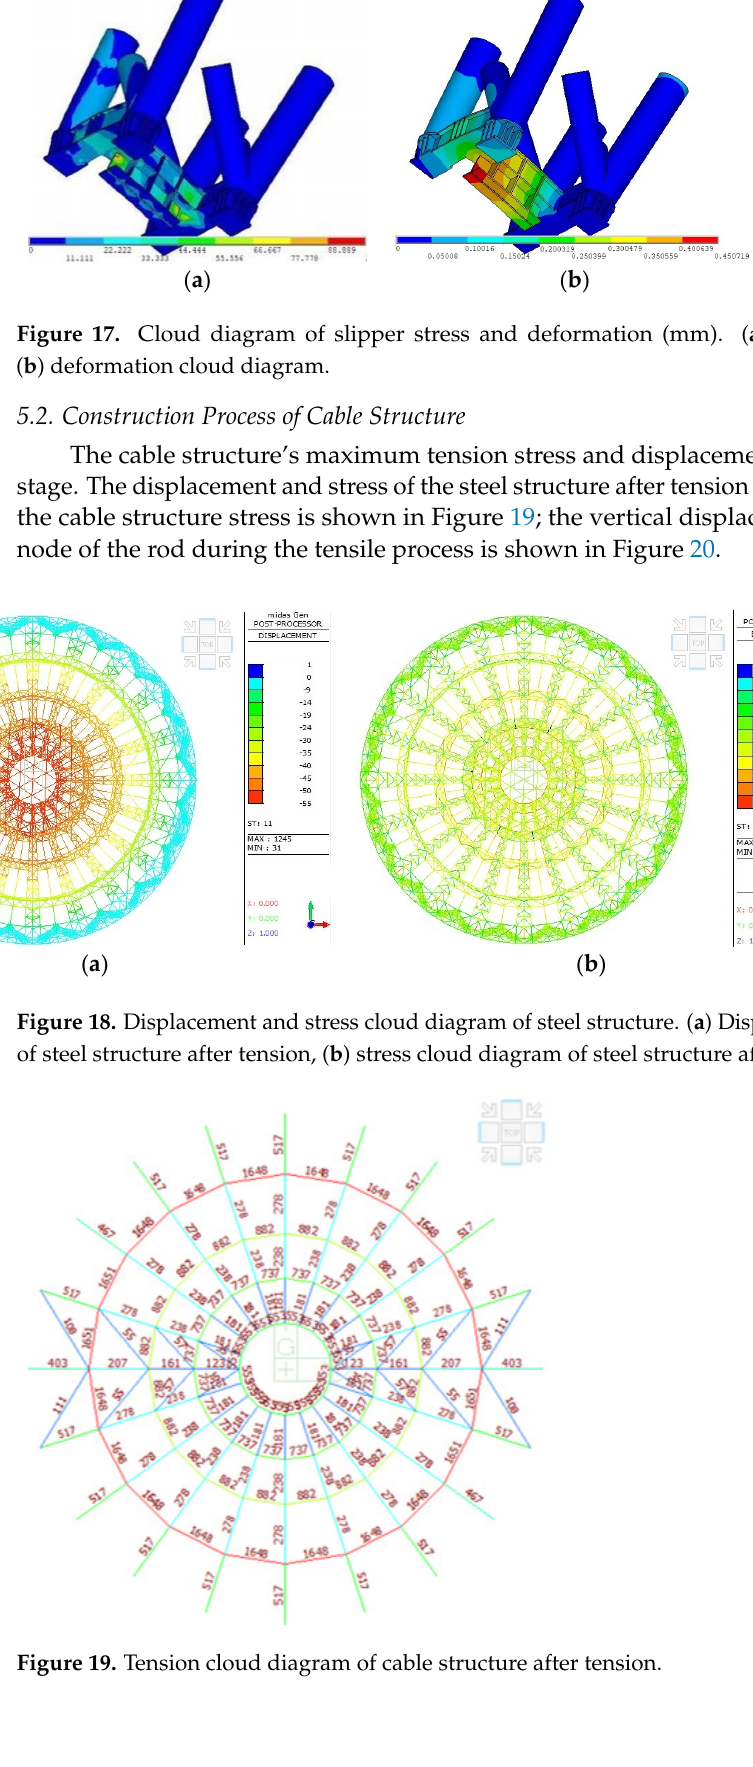
( b ) Figure 16. Deformation of an inner ring-supported tire frame (mm) (a ) X-direction, ( b ) Z-direction.